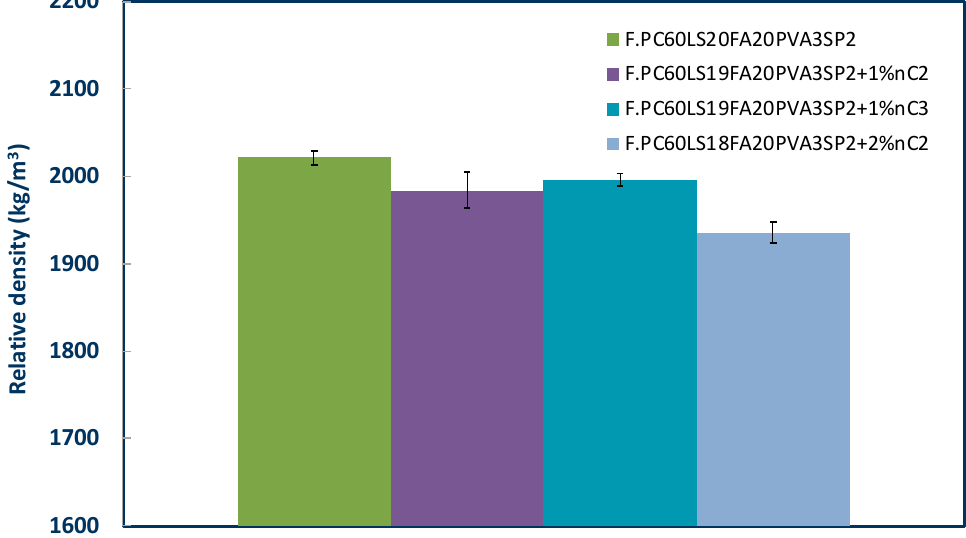
Figure 14. Effect of nMt type and concentration on long term relative density of nMt and fibre reinforced cementitious nanocomposites based on F.PC60LS20FA20PVA3SP2.